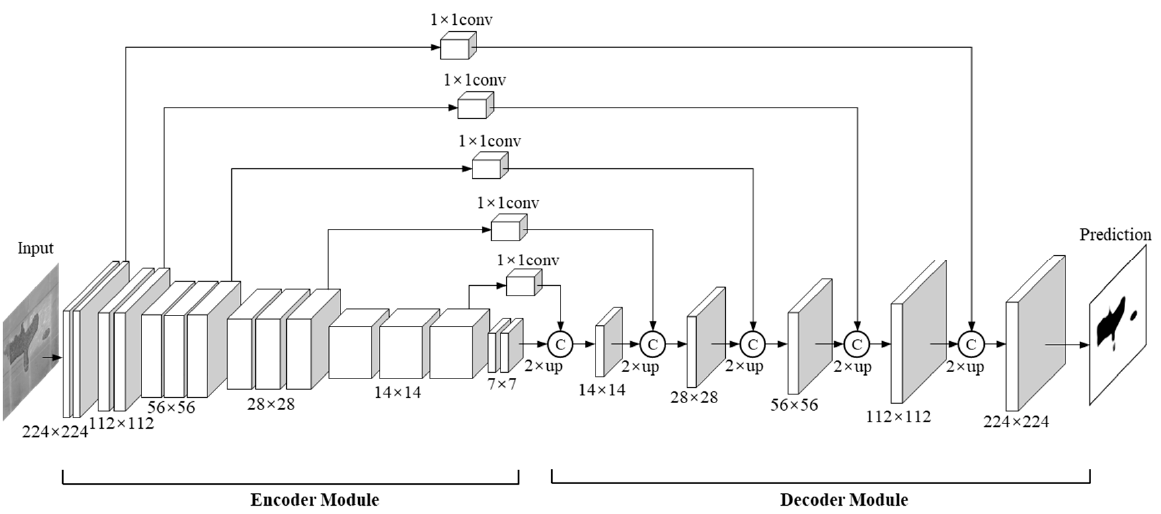
Figure 8. The structure of the three DCNNs (IntenNet, IDNet, and DepthNet). During the training and testing phase, the DCNNs are used to extract features at multiple scales through a bottom-up pathway. The encoder module is modified on the base of VGG16 through a bottom-up pathway, which includes five convolutional stages and four pooling layers. To extract a deeper semantic feature in a deeper layer, a sixth stage is added at the end of the VGG16 structure with two 3 × 3 convolution kernels. The resolution of output in the first five stages corresponds to the VGG16 network (i.e., 64 × 224 × 224, 128 × 112 × 112, 256 × 56 × 56, 512 × 28 × 28, and 512 × 14 × 14), and the resolution is 32 × 7 × 7 in the sixth